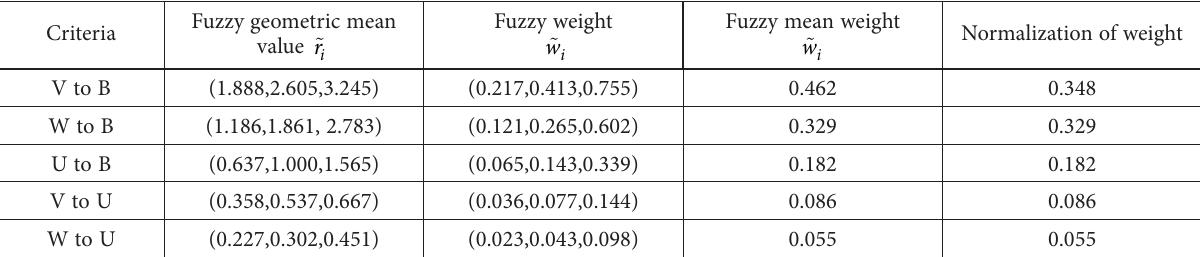
Table 7. Fuzzy geometric mean and final weight of the degradation criteria